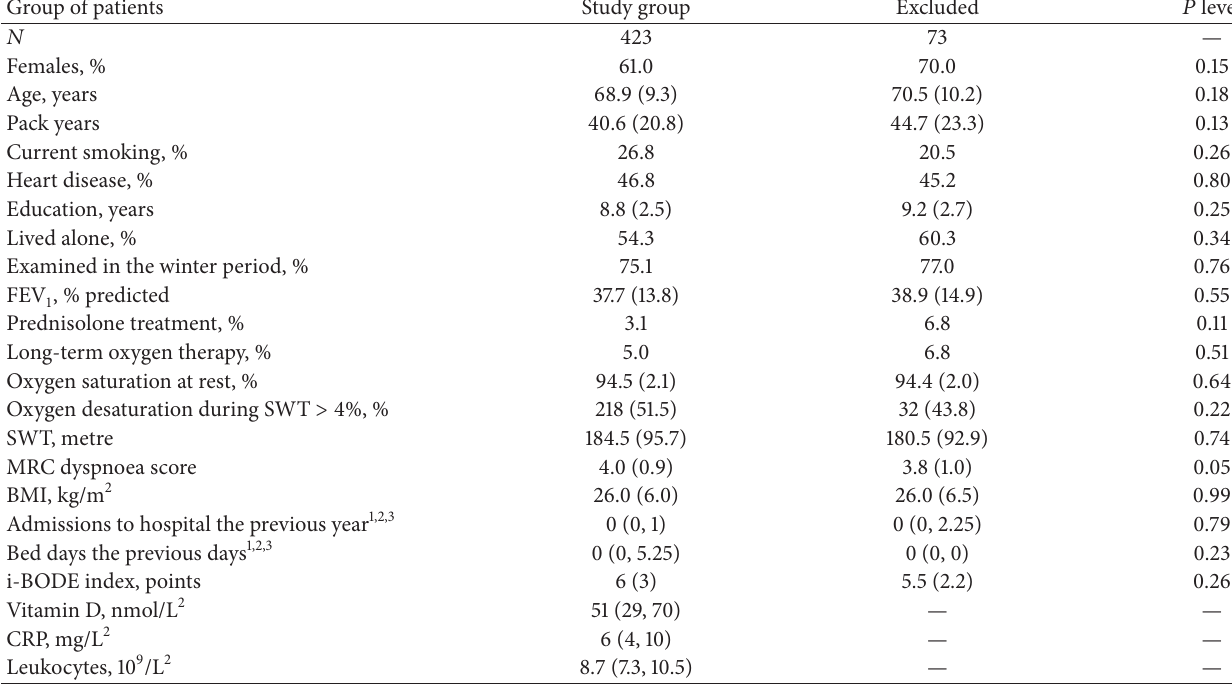
Table 2: Characteristics of patients in the study group compared with excluded patients. Group of patients